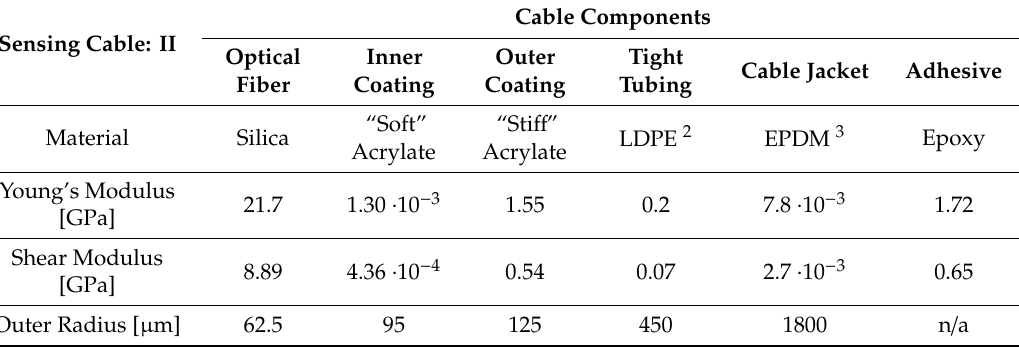
Table 2. Material properties and geometrical dimensions of the second sensing cable.